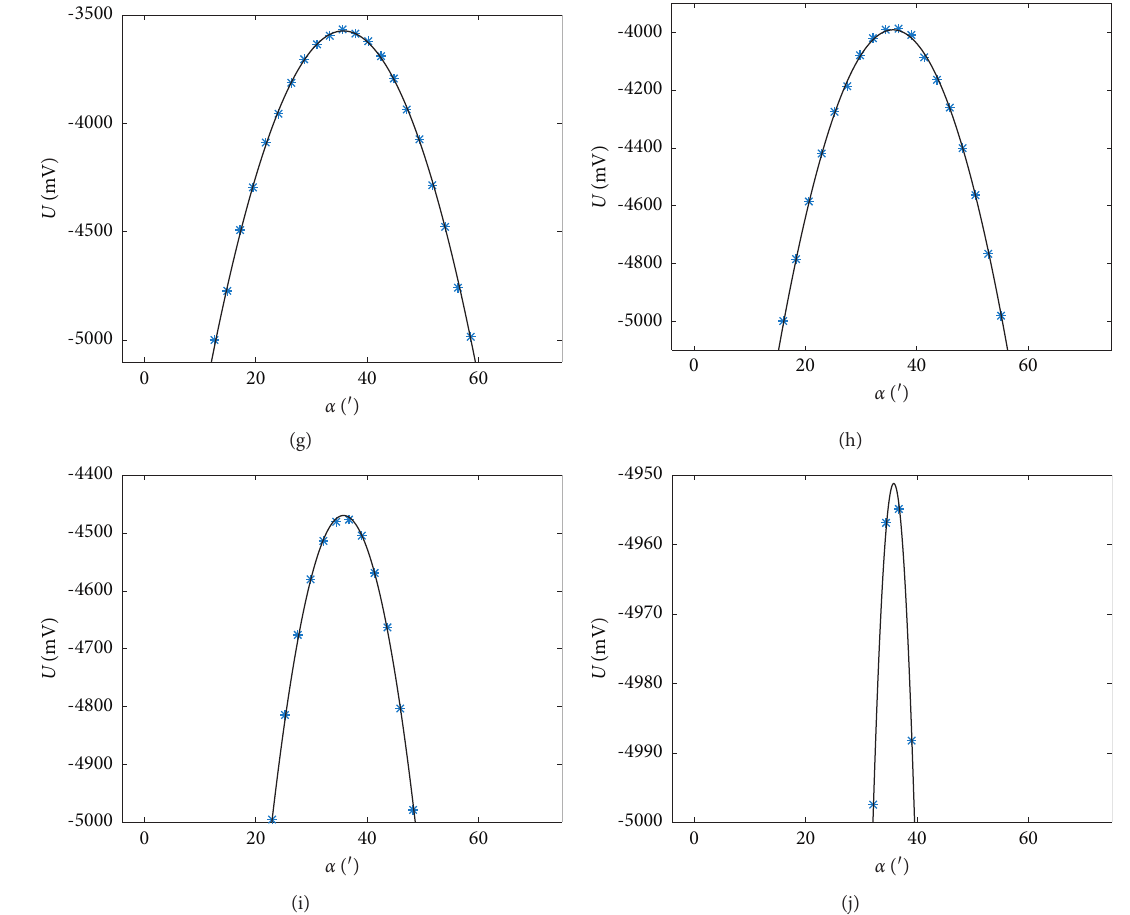
Figure 7: Static circumferential calibration curve of No. 0 blade. (a) 0.1mm. (b) 0.15mm. (c) 0.2mm. (d) 0.25mm. (e) 0.3 mm. (f) 0.35mm. (g) 0.4mm. (h) 0.45mm. (i) 0.5mm. (j)